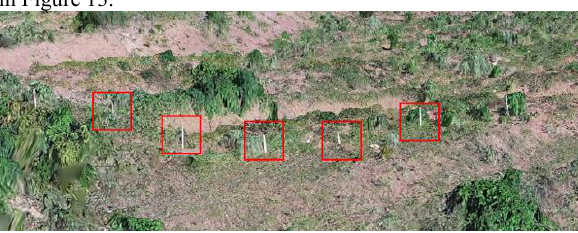
Figure 13 . Severely deformed area and GNSS calibration pile We selected 5 GNSS calibration piles from the severely deformed area, and the true deformation values are shown in Table 2. We also randomly selected 20 model points around the